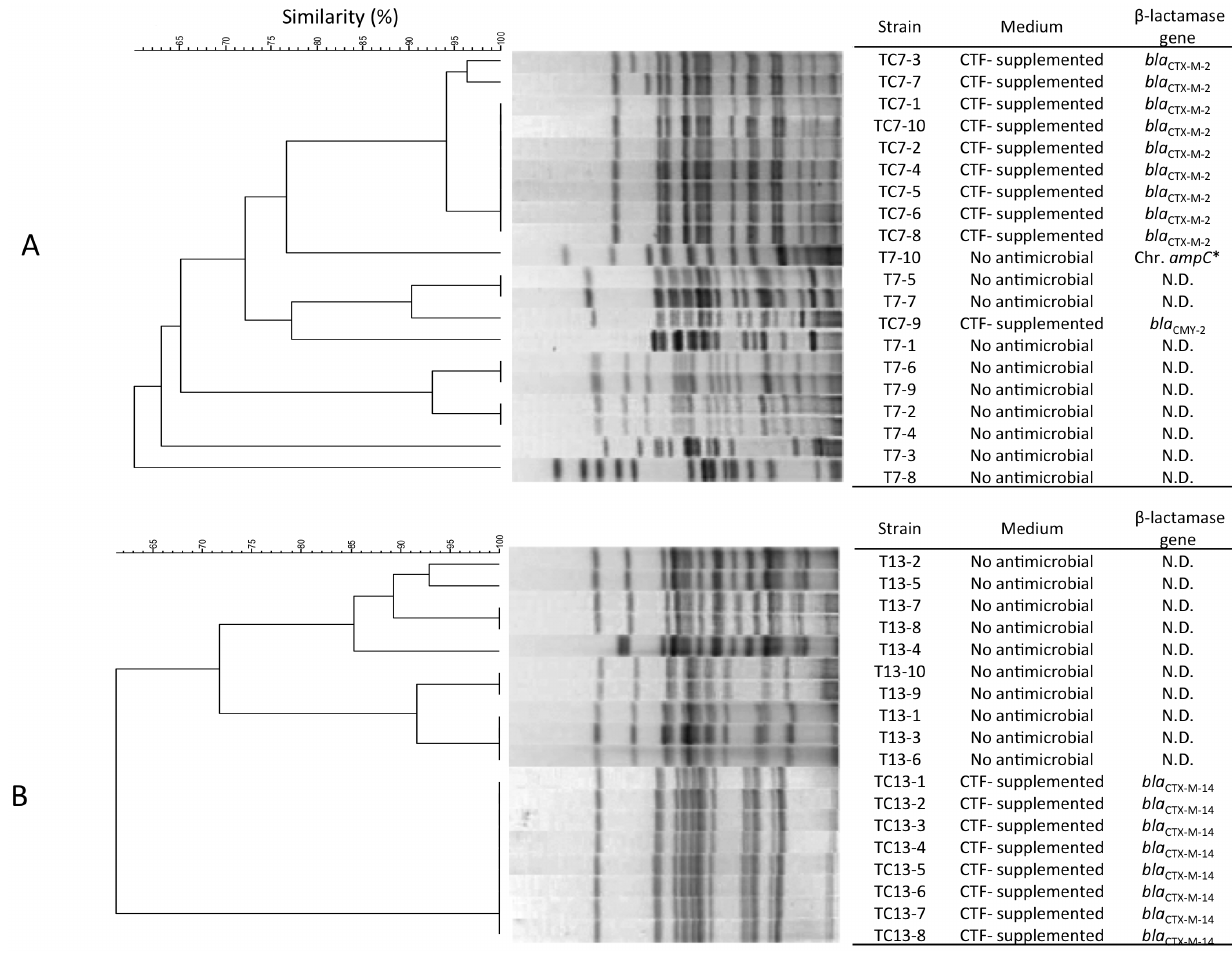
Figure 1. Pulsed-field gel electrophoresis of CTF-resistant E.coli isolates from two CTF-treated cattle. A, PFGE analysis of 20 isolates obtained from cow No. 7. Strains T7 and TC7 were isolated in the absence or presence of CTF, respectively. B, PFGE analysis of 18 isolates obtained from cow No. 13. Strains T13 and TC13 were isolated in the absence or presence of CTF, respectively.